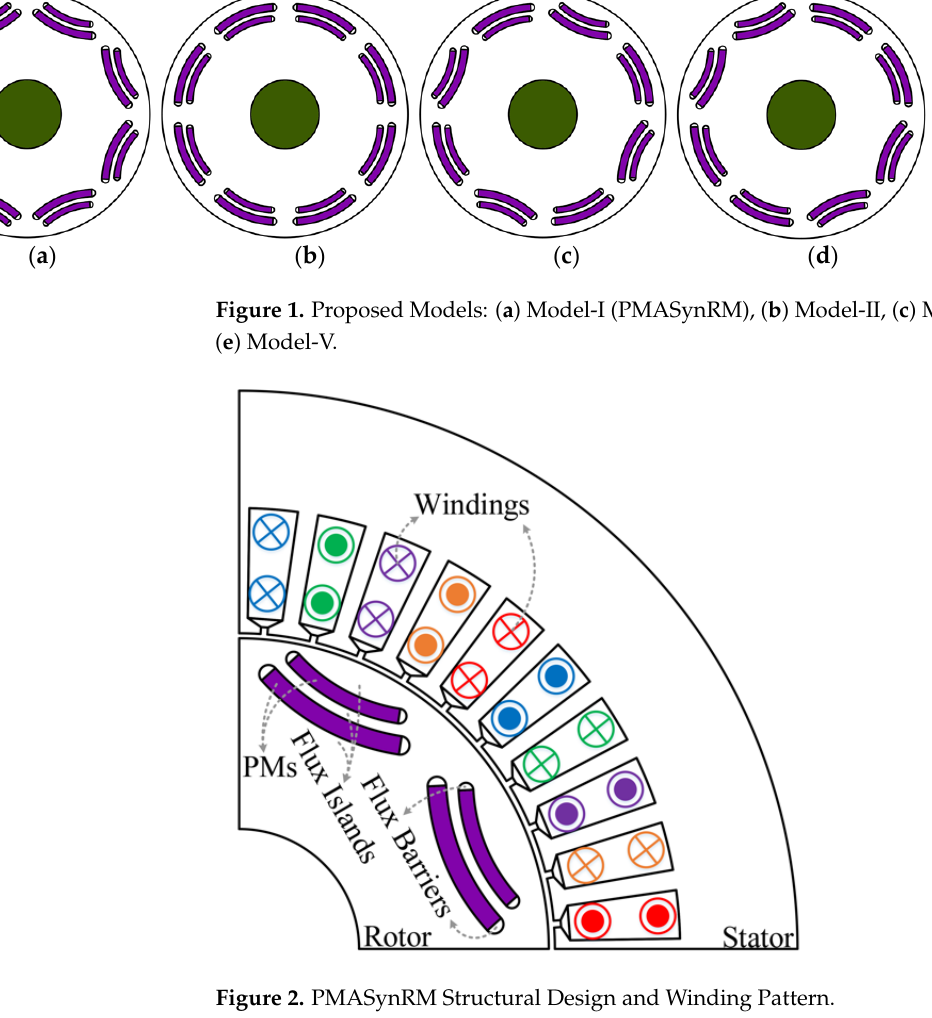
Figure 2. PMASynRM Structural Design and Winding Pattern. Table 1. Design Constrains.